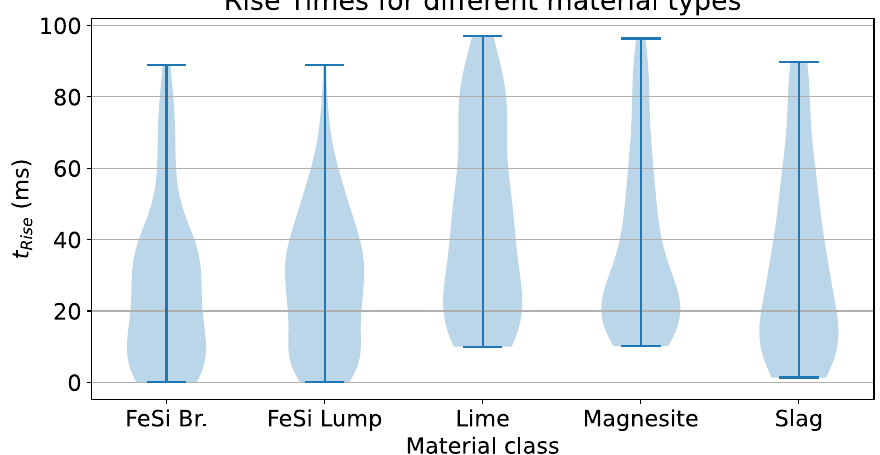
Figure 5. Rise times of characteristic dropping sound for different materials.